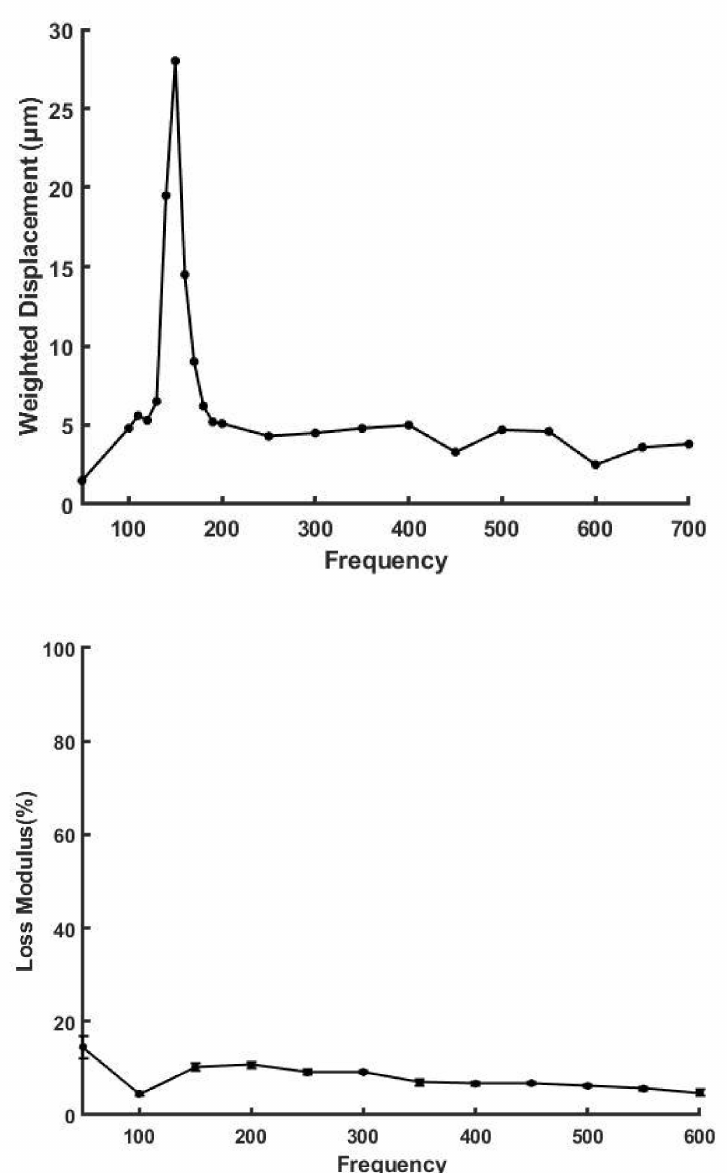
Figure 2. Weighted displacement in µ m versus frequency in Hz ( top ) and loss modulus as a percent (%) of the elastic modulus versus frequency for decellularized human skin determined in vitro using VOCT ( bottom ). Decellularized human skin is composed of primarily type I collagen fibers. Note the loss modulus of decellularized skin is very low in comparison to human skin due to the removal of proteoglycans and cells during